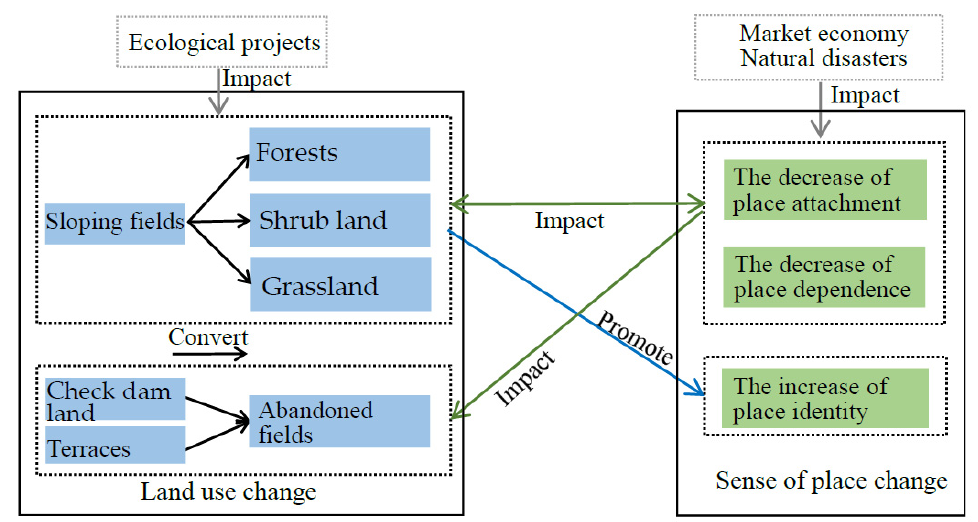
Figure 9. The interaction between land use and sense of place in the study